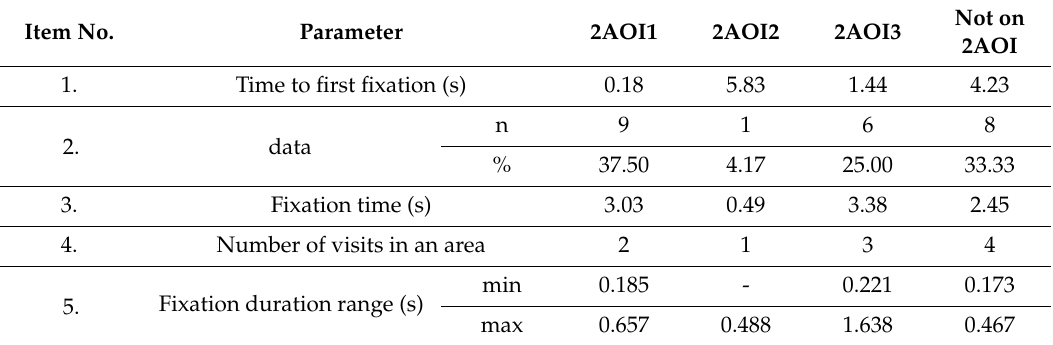
Table 4. Parameters characterising the gaze plot for one person relative to the areas outlined for analysis on image